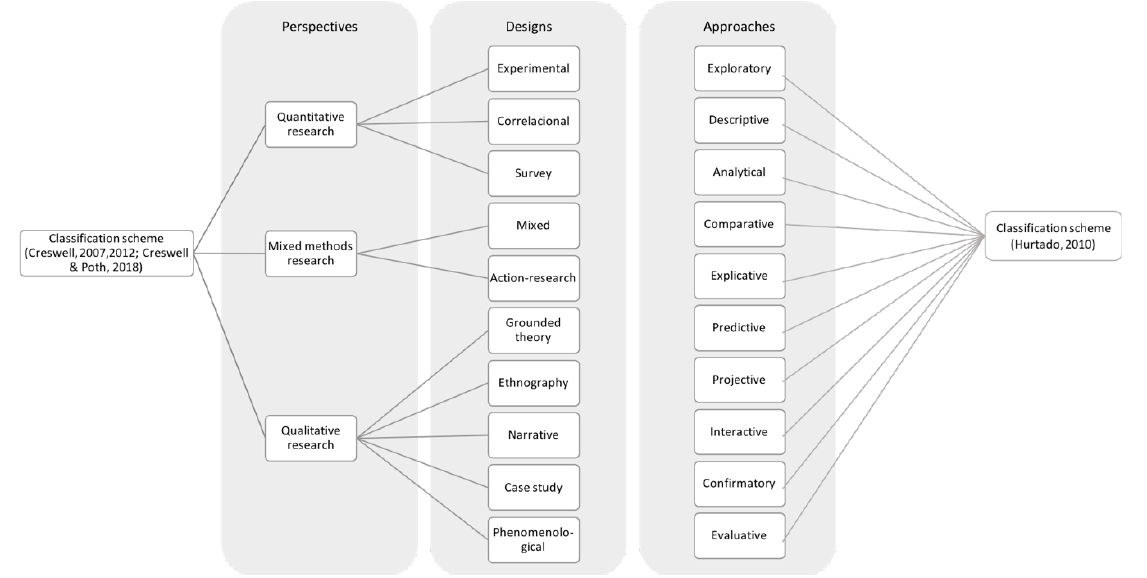
Figure 2 . Perspectives, designs, and approaches sought in educational